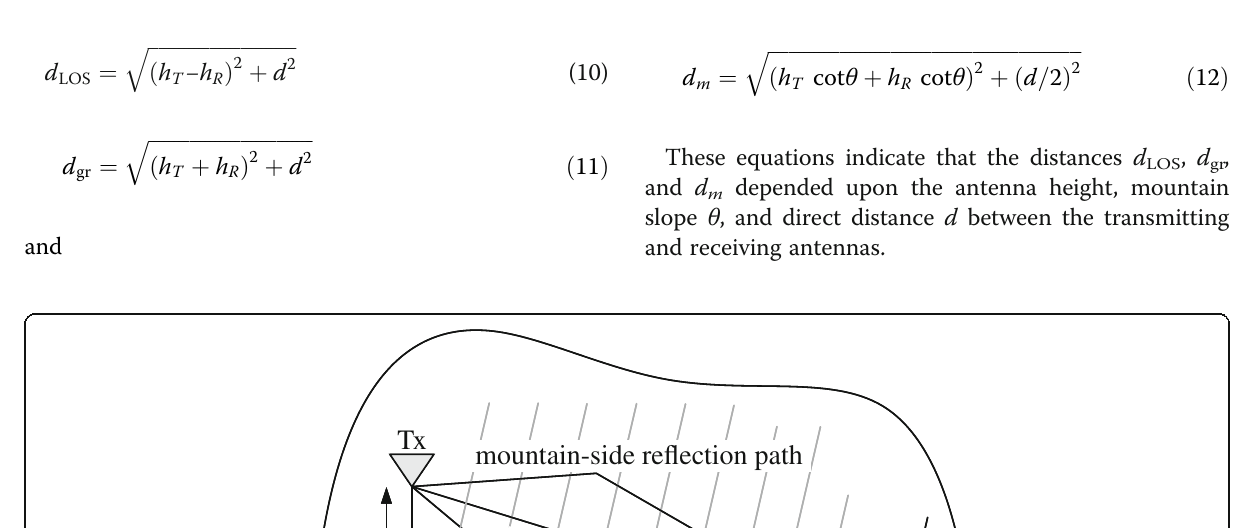
ffiffiffiffiffiffiffiffiffiffiffiffiffiffiffiffiffiffiffiffiffiffiffiffiffiffiffiffiffi